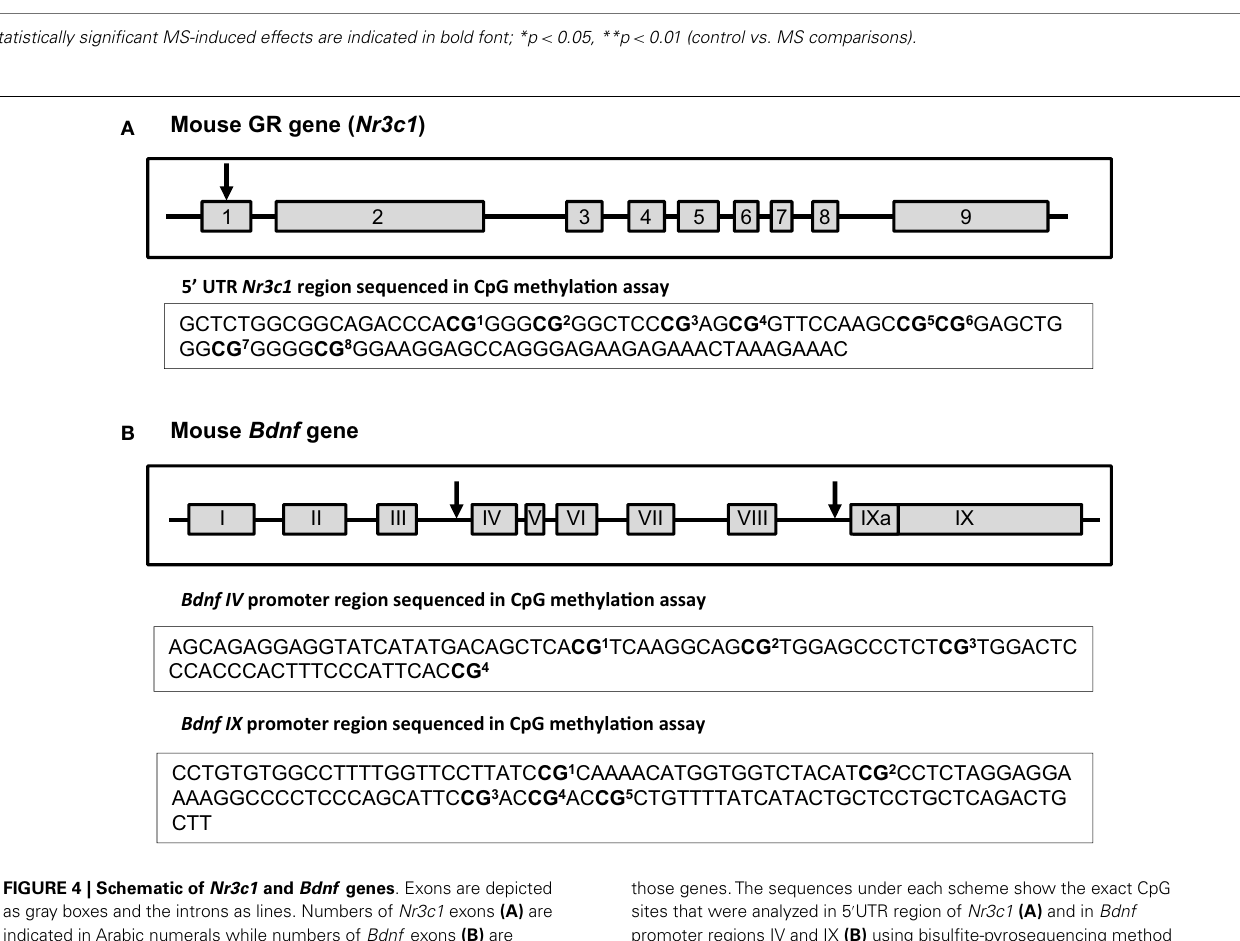
those genes.The sequences under each scheme show the exact CpG sites that were analyzed in 5 (cid:48) UTR region of Nr3c1 (A) and in Bdnf promoter regions IV and IX (B) using bisulfite-pyrosequencing method [the schemes of Nr3c1 and Bdnf genes were adapted from (67) and (68)